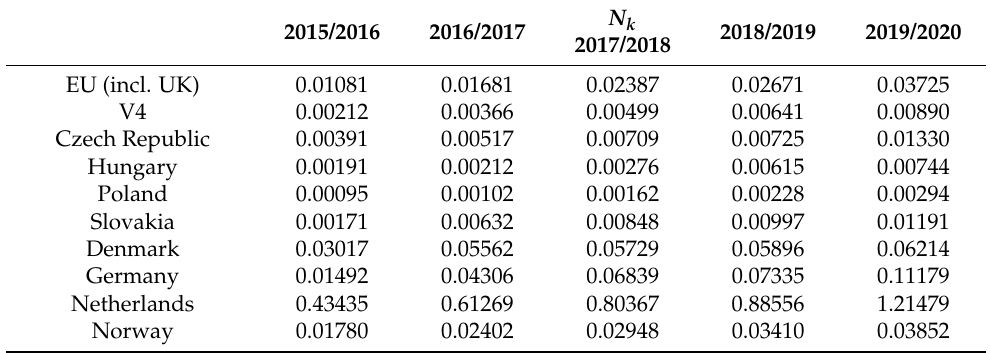
Table 9. The number of public charging stations per km 2 of the country ( N k ) at the turn of the